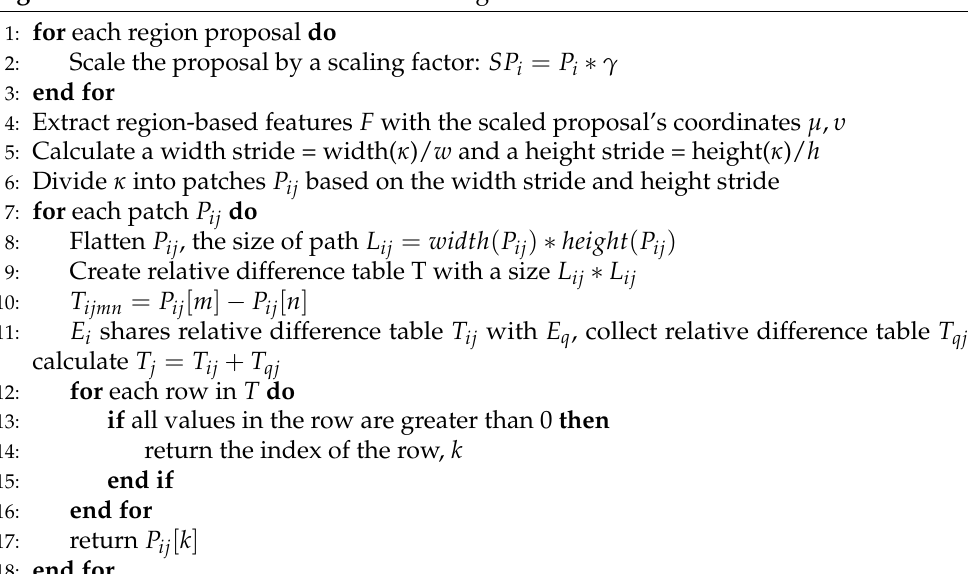
Algorithm 1 Secure Function for ROI